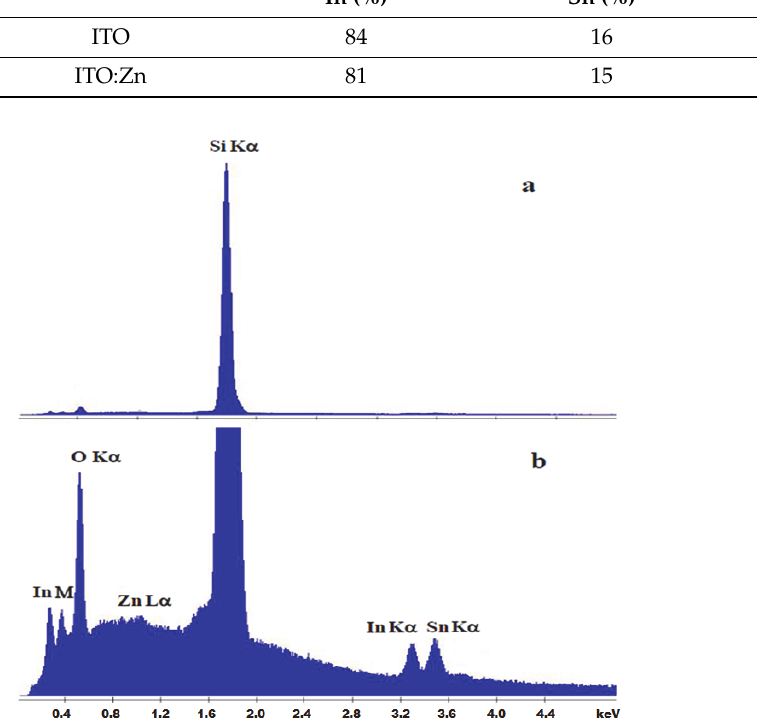
Figure 3. EDX spectrum of ITO:Zn film on Si: ( a ) full spectrum, showing the Si K α line from the substrate and small contributions of the O K α , In M, In K α , Sn K α , and Zn L α peaks from the film; ( b ) magnified view of the peaks from the film.